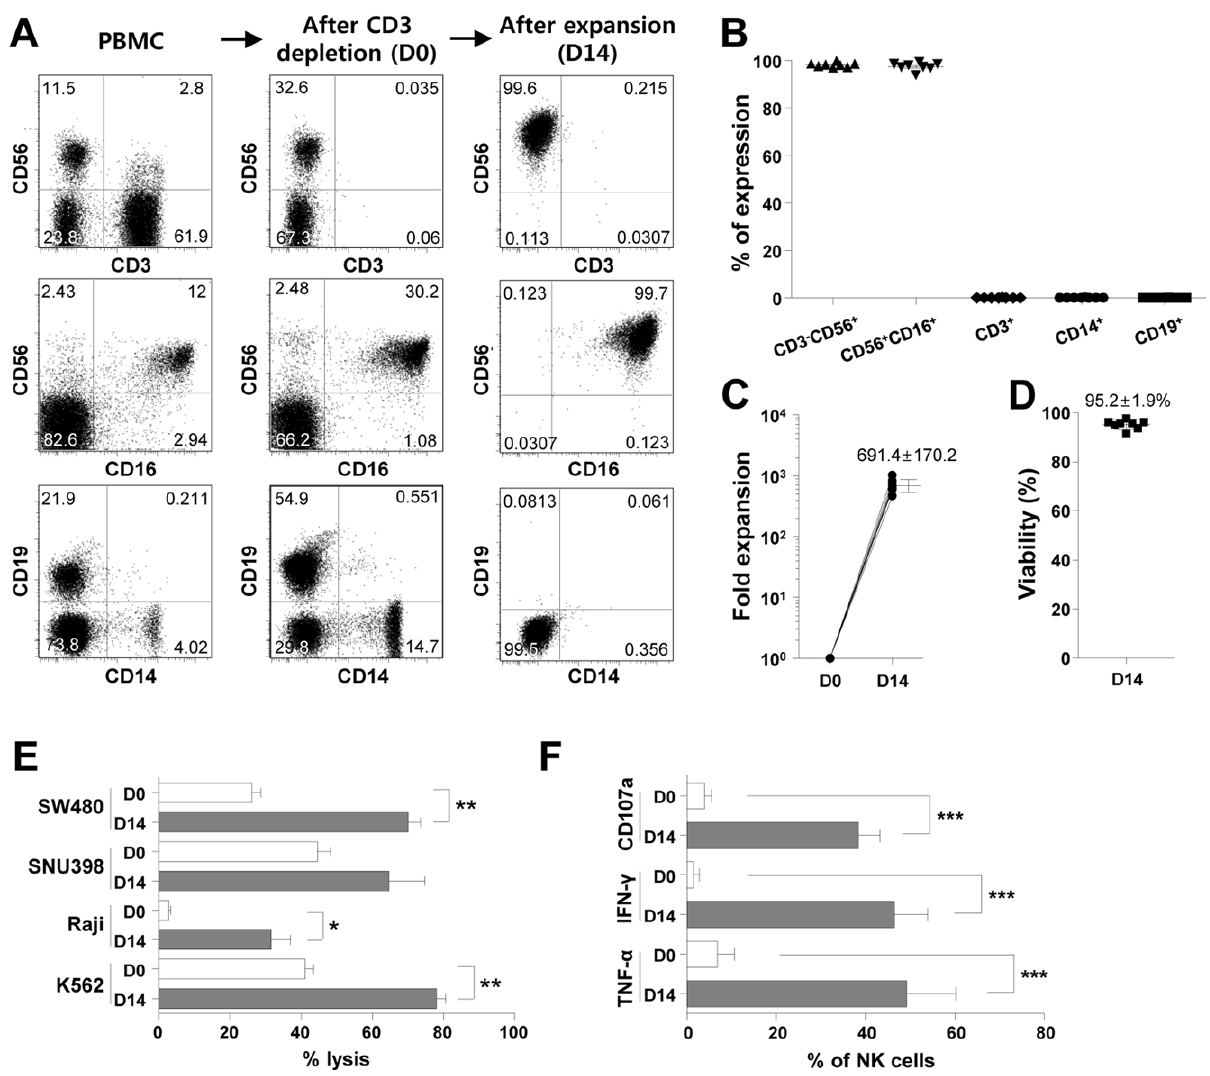
Figure 1. Characterization of large-scale GMP-expanded NK cells. (A–B) T-cell depleted PBMCs were expanded under the GMP conditions described in the Materials and Methods. The percent of CD3 2 CD56 + , CD56 + CD16 + , CD3 + , CD14 + and CD19 + cells were analyzed by flow cytometric analyses (B, n=8). Representative FACS dot plots are presented (A). (C) The fold expansion of NK cells was determined before (D0) and after (D14) NK cell expansion (n=8). (D) The viability of expanded NK cells was evaluated by staining of propidium iodide. (E) Cytotoxicity of NK cells against various tumor cells was compared before (D0) and after (D14) NK cell expansion (n=4). The effector:target ratio was 10:1. (F) NK cells were cocultured with K562 cells at 1:1 ratio for 4 h, and staining for intracellular cytokines (IFN- c and TNF- a ) and CD107a was performed as described in the Materials and Methods. The data were compared before (D0) and after (D14) expansion. Mean and SD are presented. * p , 0.05; ** p , 0.01; *** p , 0.001.